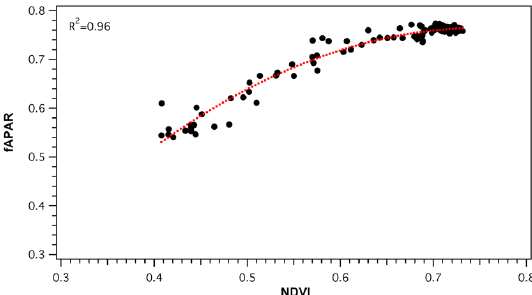
Figure 9. NDVI- f APAR relationships derived from daily values. NDVI was calculated from broadband spot radiometer sensors. f APAR was derived from the wireless sensor network (WSN) composing of 36 nodes measuring canopy transmitted light. Dotted line represents polynomial regression fitted to the data: y = − 1.9596 χ 2 + 2.954x − 0.3484, R 2 = 0.96.